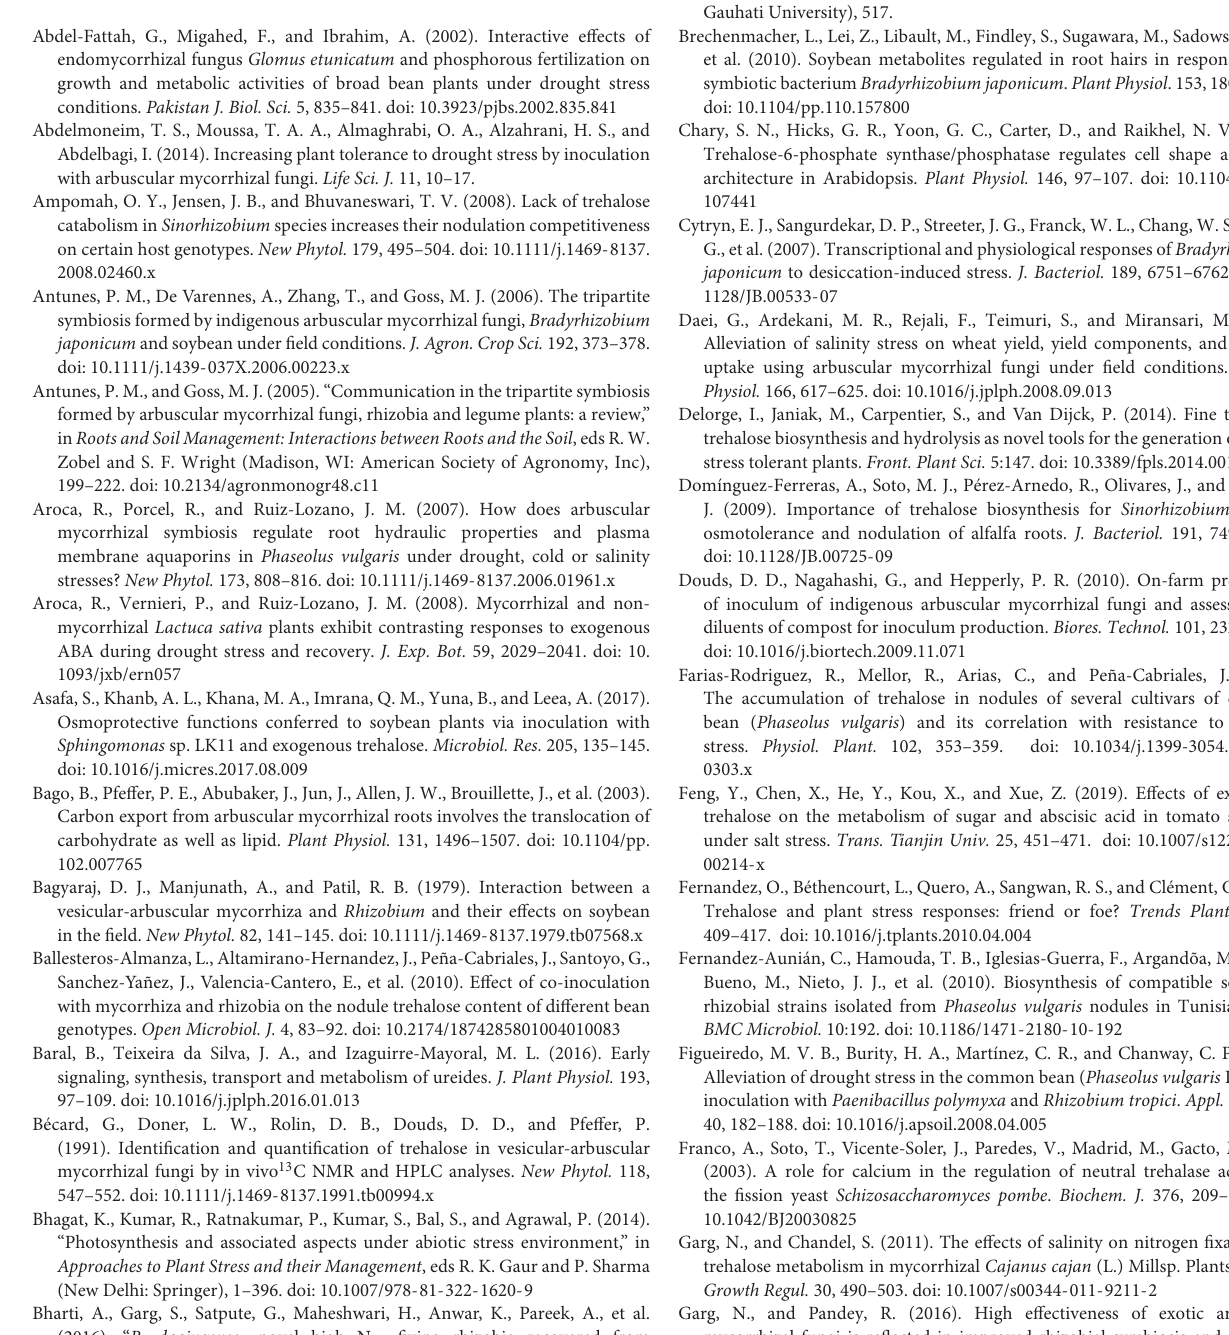
turnover in Cajanus cajan genotypes grown under salinity stress. Fungal Ecol. 21, 57–67. doi: